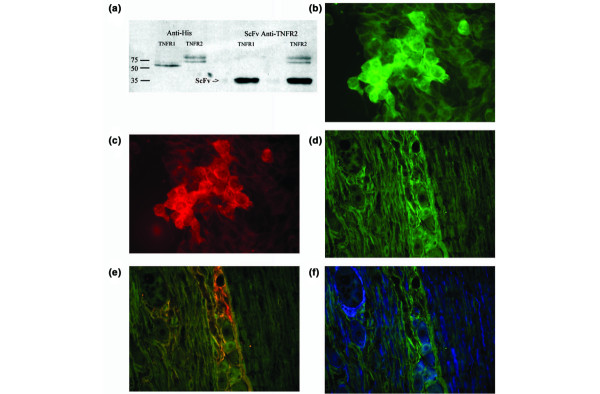
Monitoring expression of TNFR2 with anti-TNFR2 single-chain variable fragment (ScFv). (a) Immunoprecipitation of His-tagged tumour necrosis factor types 1 and 2 (TNFR1 and TNFR2) with anti-His antibody (left panel), and anti-TNFR2 single-chain variable fragment (ScFv) (right panel). The ScFv precipitated TNFR2, at ~75 KDa, but not TNFR1, at ~55 KDa, while the anti-His antibody precipitated both receptors, indicating specificity of the ScFv. Double immunohistochemistry against TNFR2-transfected 293T cells with anti-His antibody (b), and ScFv plus anti-myc-CY-3 (c) indicates that the selected ScFv specifically binds toTNFR2. (d) Immunohistochemistry with anti-TNFR2 ScFv in the dorsal root ganglion 7 days after inflammation ipsilateral to injection. TNFR2 colocalisation was observed with the macrophage marker, ED1 (e) but not with glial fibrillary acidic protein (GFAP) (f), indicating expression of TNFR2 by macrophages following inflammation.